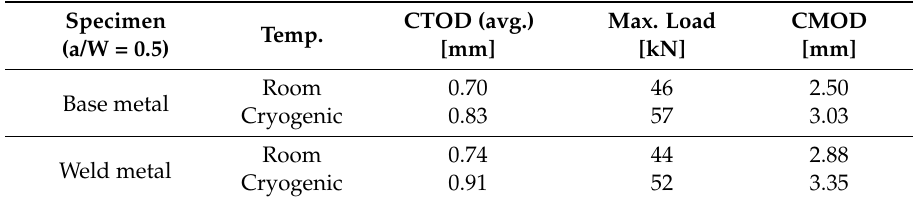
Table 4. Fracture toughness of the base metal and weldments for Al 5083-O.